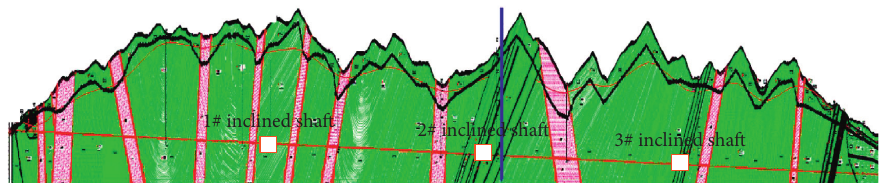
Figure 3: Geostress test location and geological cross-section along the tunnel route.